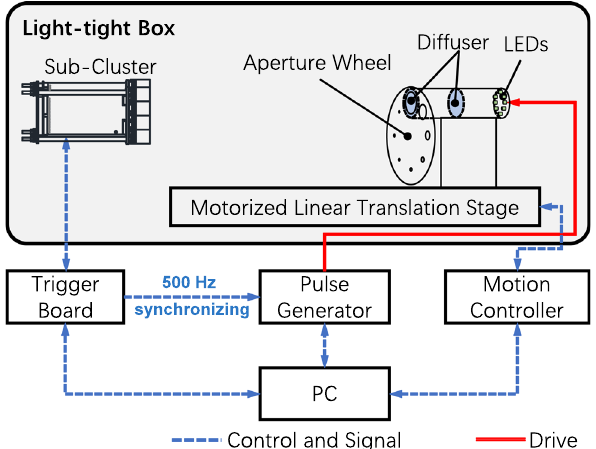
Fig. 10 Scheme of the 1D-System. The rounded rectangle represents the light-tight box, which is utilized to provide the dark environment required for tests. The light source is composed of eight LEDs, two diffusers and an exit aperture wheel. The sub-cluster to be tested is illuminated by diffused light whose flux is controlled by the distance from the light source to the SiPM and the exit aperture